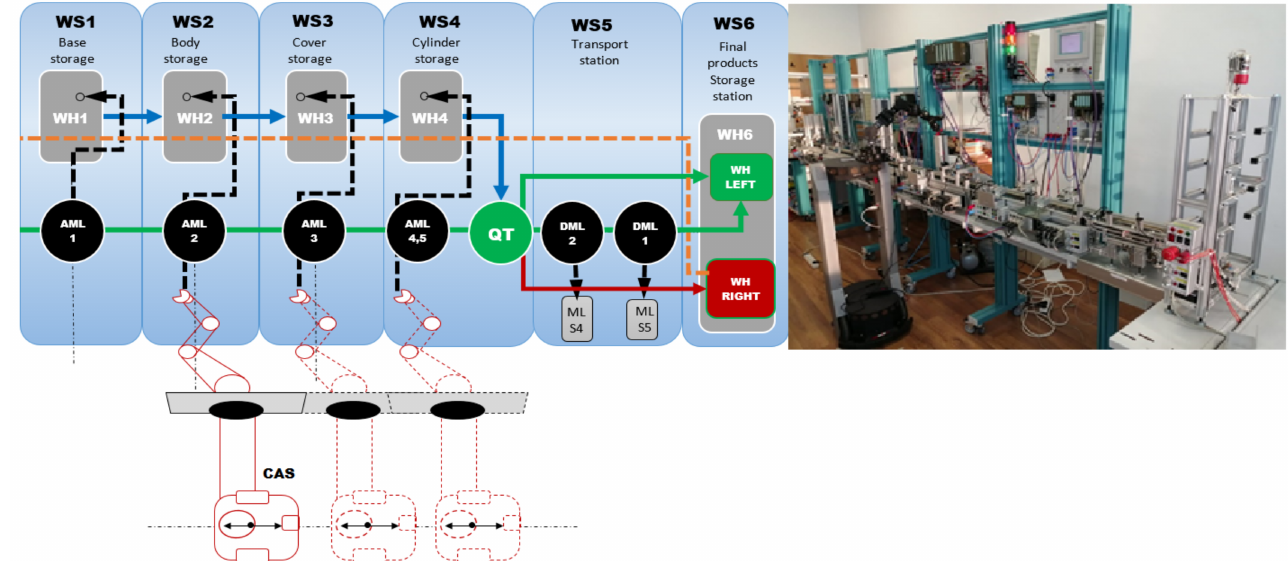
Figure 4. A/DML Hera&Horstmann ML with symmetrical final product storage.